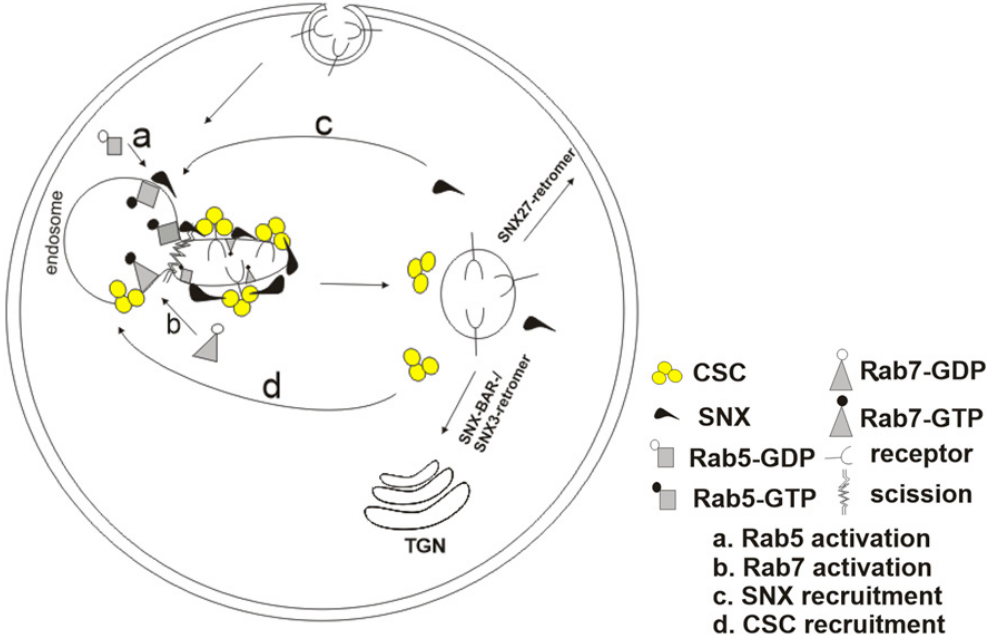
Figure 2. Recruitment of retromer to the endosome and the fission of the vesicle after its exit from the endosome. Activated Rab5 and Rab7 (Rab5-GTP and Rab7-GTP, respectively) recruit the SNX and CSC subcomplexes, respectively, to the endosomal membrane. The retromer subcomplexes assemble SNX proteins, and subsequent vesicle scission. Further fission of the vesicle occurs downstream of its endosome exit for cargoes taking different itineraries.